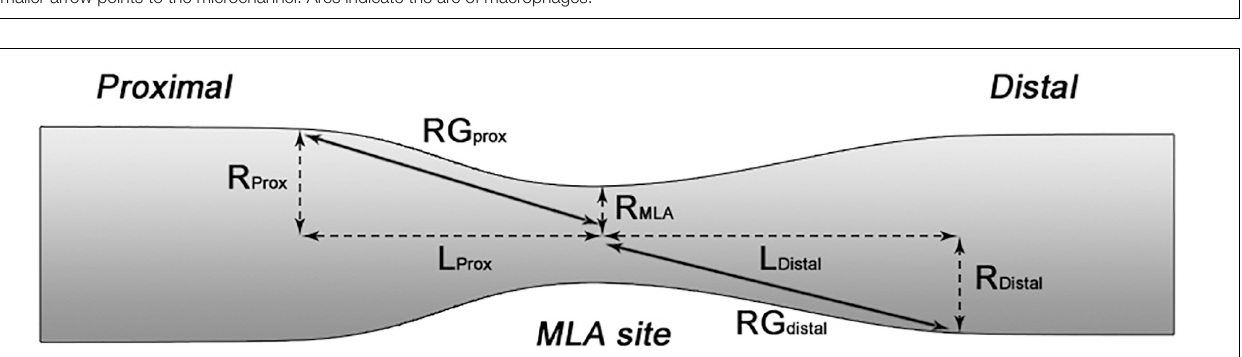
FIGURE 1 | Representative images and methodology of OCT morphology analysis. The upper part is a representative longitudinal diagram of a ruptured plaque (blue dots represent for macrophages while yellow sharp stars for cholesterol crystals, gray curved lines for microchannels), panels (A–E) are cross sections corresponding to the lesion segment while analyzed at 0.4 mm interval. (A) The reference segment of the vessel, red line indicates the lumen surface while green line indicates the EEM. (B) Calcification tissue in the plaque, the arc indicates the calcific arc. (C) Lipid tissue in the plaque, the arc indicates the lipid arc, the area enclosed by the blue line indicates the fibrous cap. Yellow and green lines which are vertical to the lumen border are maximum and minimal cap thickness respectively. (D) Plaque rupture and thrombus. Red line represents the lumen surface while red dash line indicates the lumen surface before plaque rupture. The white arc represent rupture circumferential extend, while yellow arc indicates thrombus circumferential distribution for generating the thrombus score. Line with arrowheads represents the depth of rupture. (E) Macrophages, cholesterol crystals, and microchannels. The bigger arrow points to the cholesterol crystals while the smaller arrow points to the microchannel. Arcs indicate the arc of macrophages.